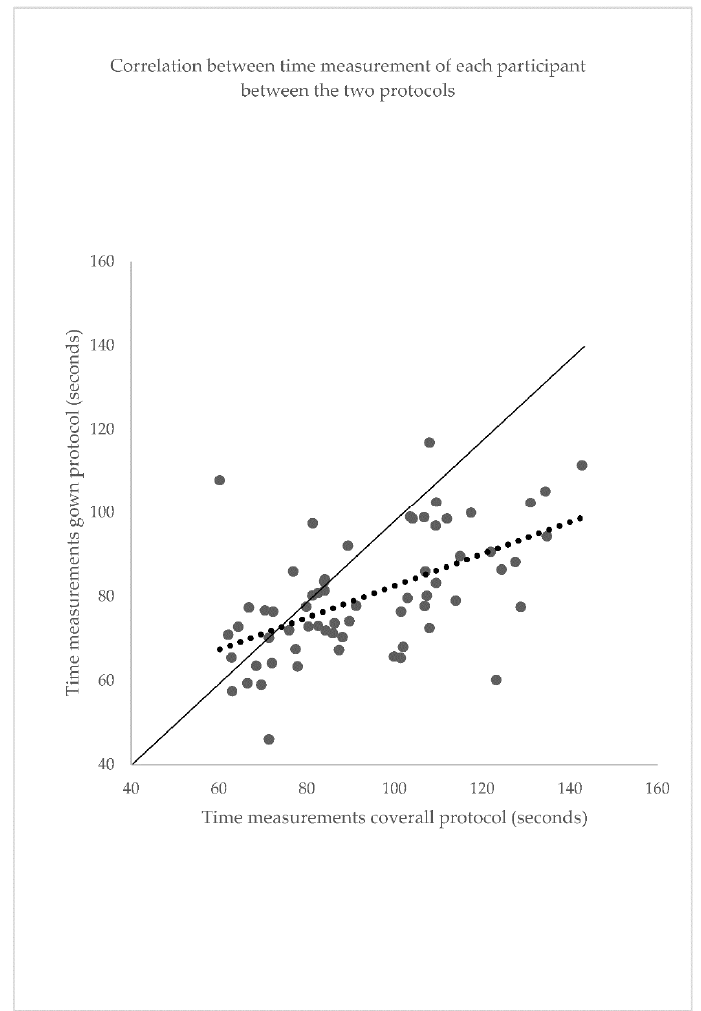
Figure 3. Comparison of time measurements of each participant between the two protocols examined in the study: coverall protocol and gown protocol. The solid line represents the equality line, and the dotted line is the trendline of the measurements.